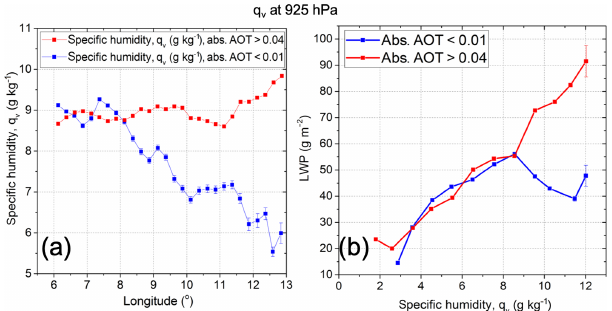
Figure 11. Mean values of specific humidity at 925hPa as a func- tion of longitude (a) and LWP versus ERA-Interim specific hu- midity at 925hPa (b) . The data are separated into situations with POLDER absorption AOT 865nm smaller than 0.01 (red lines) and with POLDER absorption AOT 865nm larger than 0.04 (blue lines).